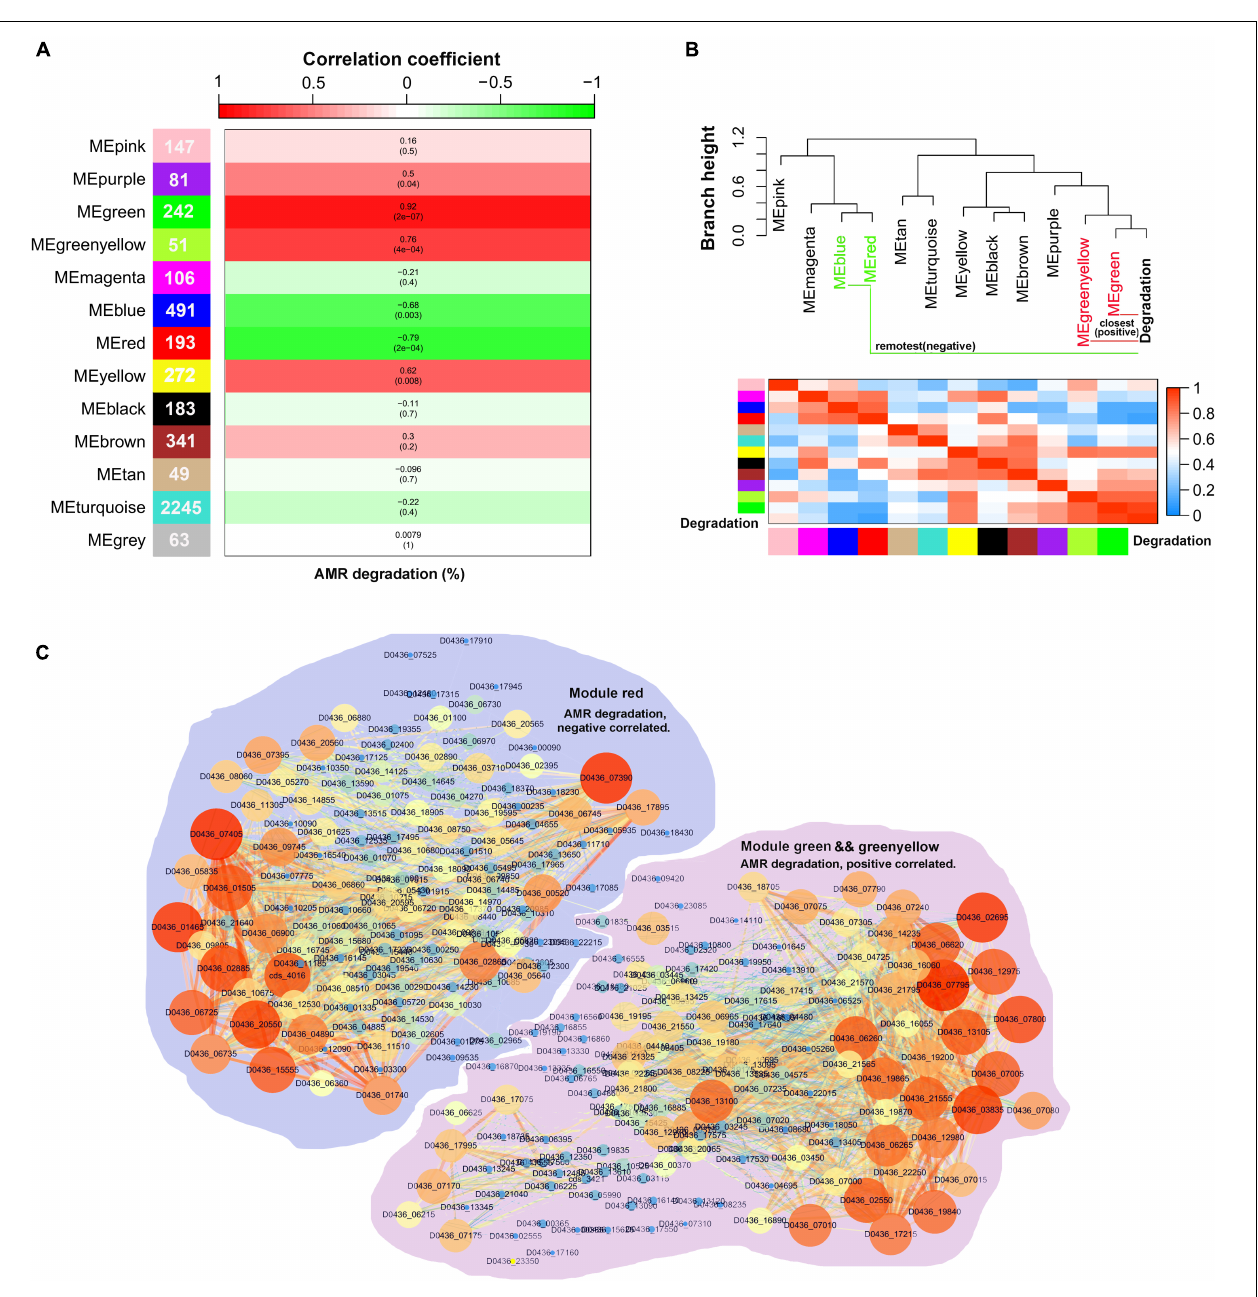
FIGURE 5 | Visualization of the correlations between the co-expression gene modules and the sample traits. Numbers in the cells of the left color bar represent gene numbers contained in the corresponding modules. The top color bar represents the module–trait correlation coefficient ranging from -1 to 1. The color in the cells of the middle columns represents the correlation marked by the top color bar, numbers in the brackets were the p -value, and numbers outside the brackets were the correlation coefficient. A combination of p ≤ 0.05 and correlation coefficient ≥ 0.75 or ≤ -0.75 were identified as significantly correlated pairs (A) . The module–trait dendrogram and adjacency heatmap (B) . Co-expression networks of the AMR degradation correlated gene modules. Node size in the network represents its connectivity; the bigger the node size, the more the connections. Node label color represents the genes’ module membership (MM), the higher MM is displayed by the brighter color (C)